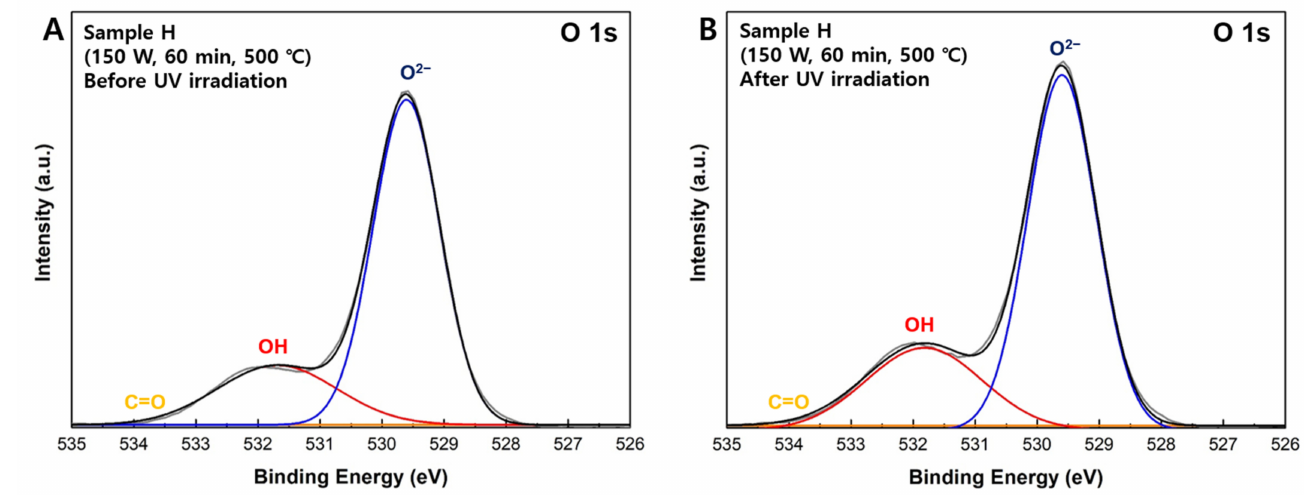
Figure 6. XPS spectra of O 1s ( A ) before UV irradiation and ( B ) after UV irradiation.